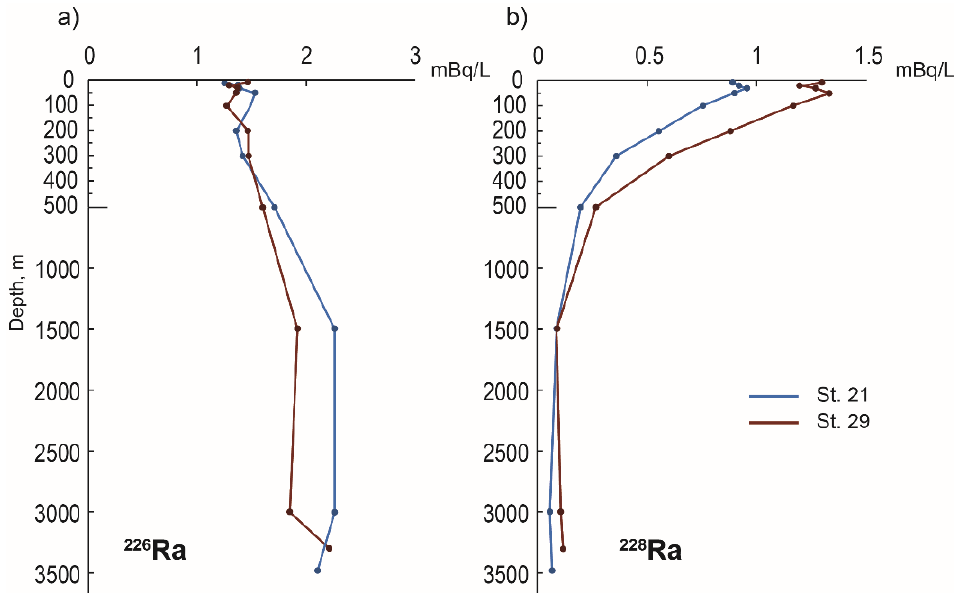
Figure 3. Vertical profiles of 226 Ra ( a ) and 228 Ra ( b ) activities at the sampling stations in the Japan Basin.